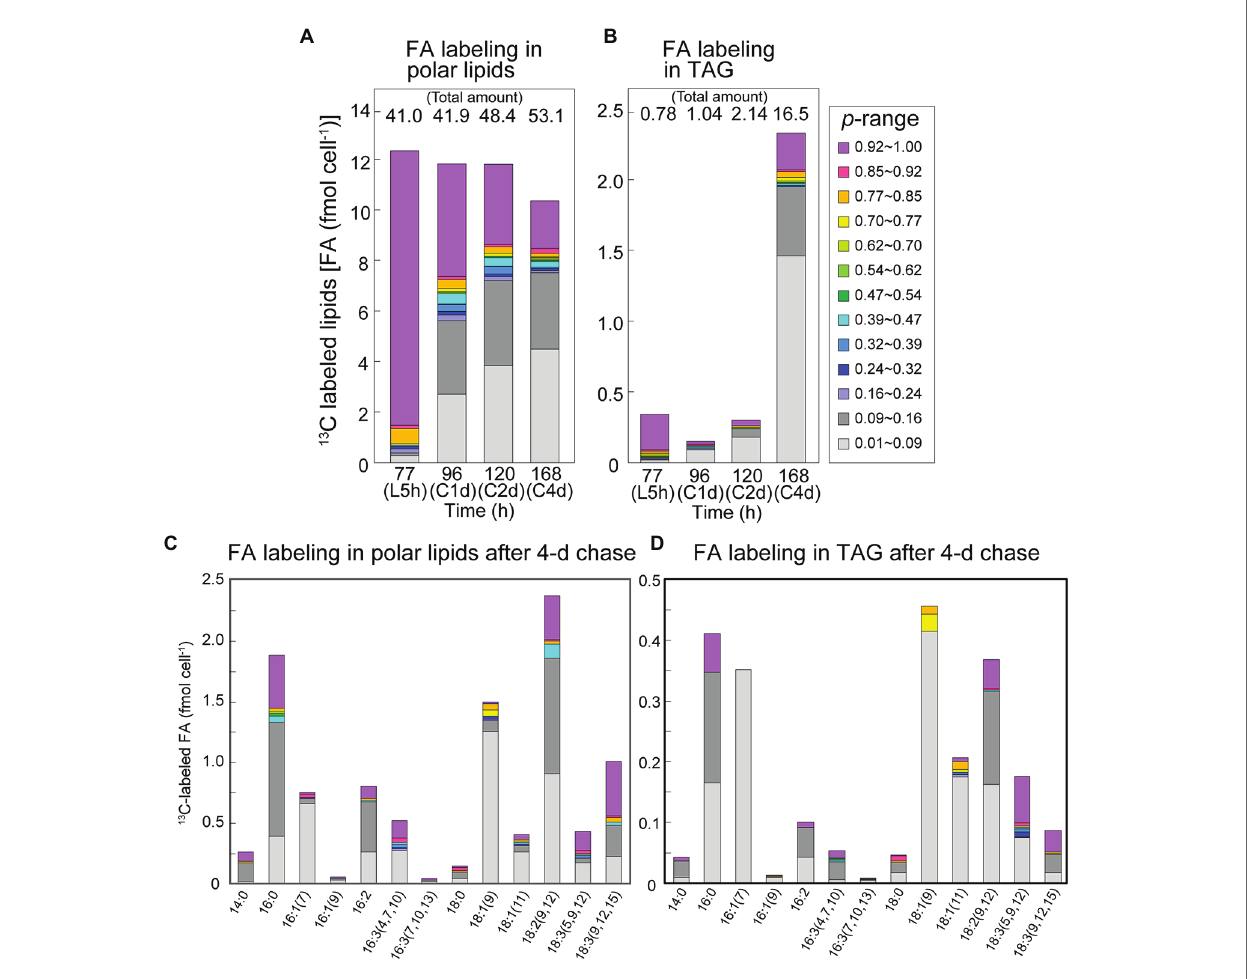
FIGURE 7 | Fatty acid labeling in polar lipids and TAG in the [ 13 C]bicarbonate labeling and chase experiments. (A) Composition of isotopic abundance populations in the fatty acids of polar lipids. (B) Composition of isotopic abundance populations in the TAG fatty acids. Total amount of lipids (as fatty acids) is shown on top. (C) Composition of labeled populations of fatty acids in polar lipids after the chase for 4 days. (D) Composition of labeled populations of fatty acids in TAG after the chase for 4